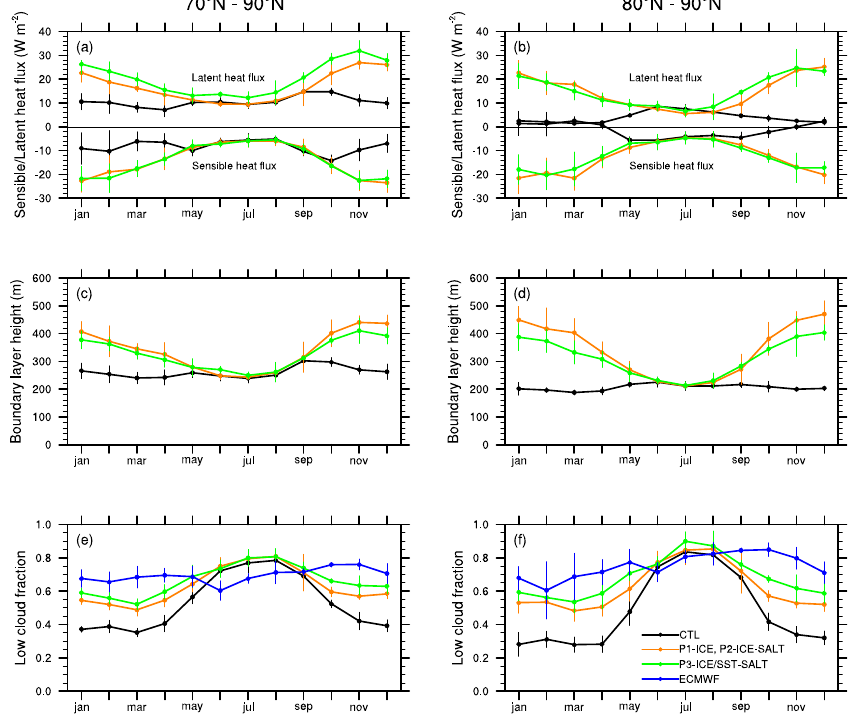
Fig. 6. Modeled boundary layer response to changes in Arctic sea ice. (a) , (b) average (ocean grid points only) surface latent and sensible heat flux, (c) , (d) boundary layer height and (e) , (f) low cloud fraction. Values are averages over the final five years of the model integrations. Vertical lines indicate two standard deviations corresponding to the monthly